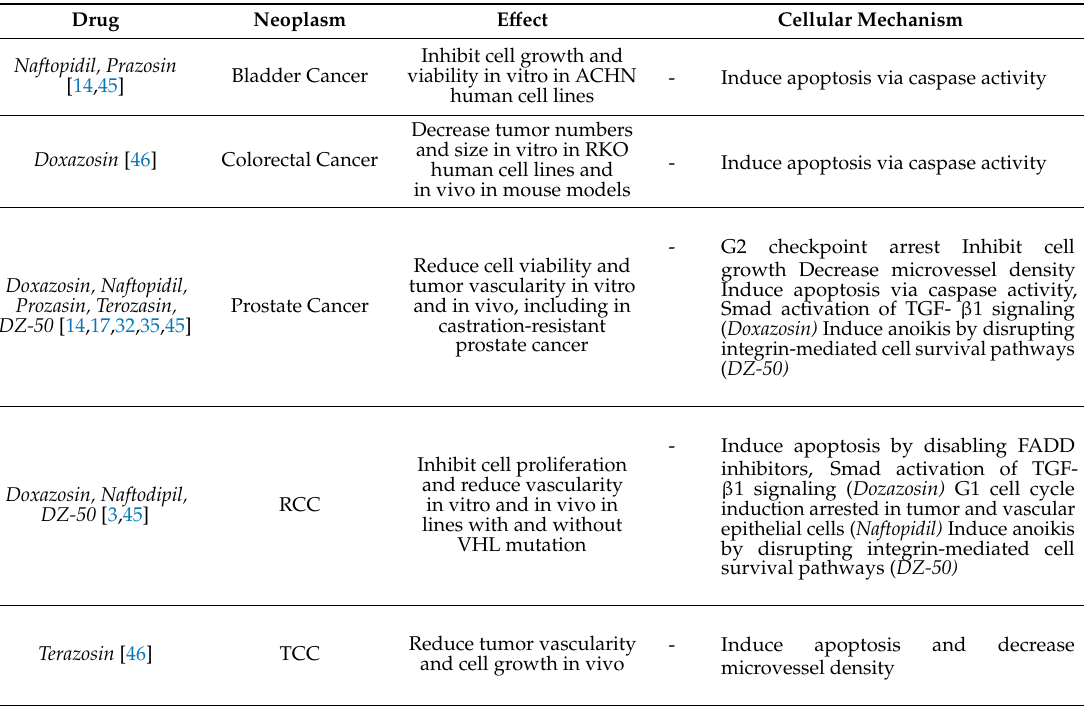
Table 1. Therapeutic Impact of α 1-Adrenoreceptor Antagonists Use against Human